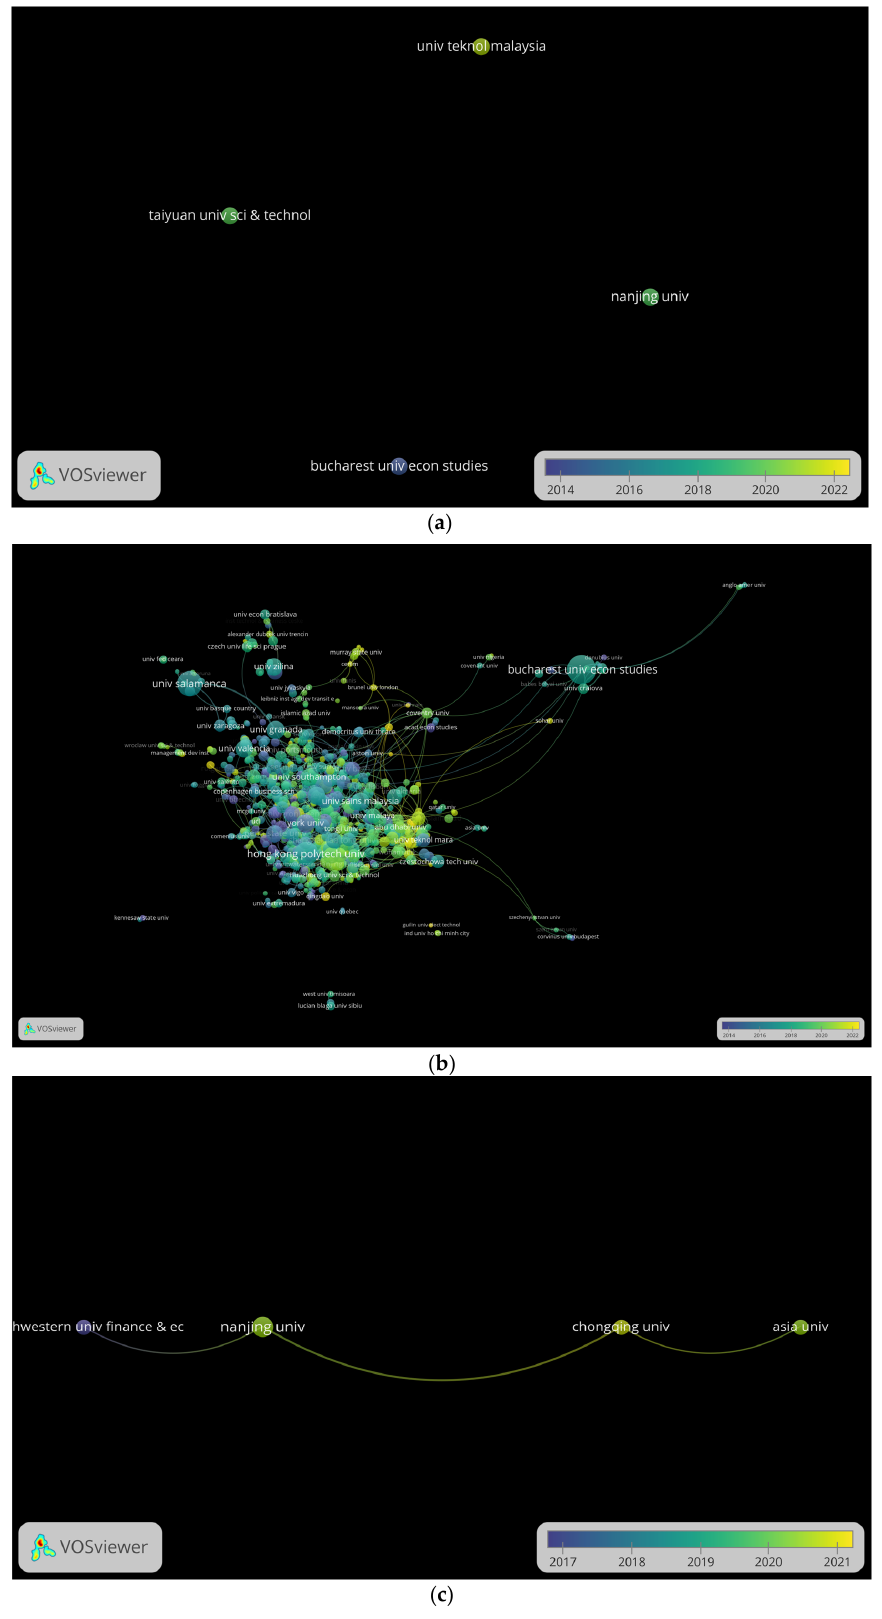
Figure 3. ( a ). Institutions’ co-authorship network regarding CSR, environment and energy policy. ( b ). Institutions’ co-authorship network regarding CSR and environment. ( c ). Institutions’ co-authorship network regarding CSR and energy policy.